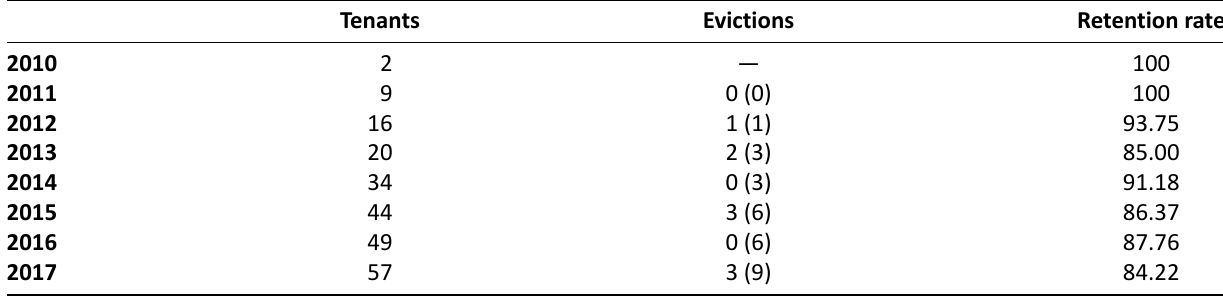
Table 1. Housing First in Helsingborg 2010–2017 (number of tenants, evictions and housing retention rate). Tenants